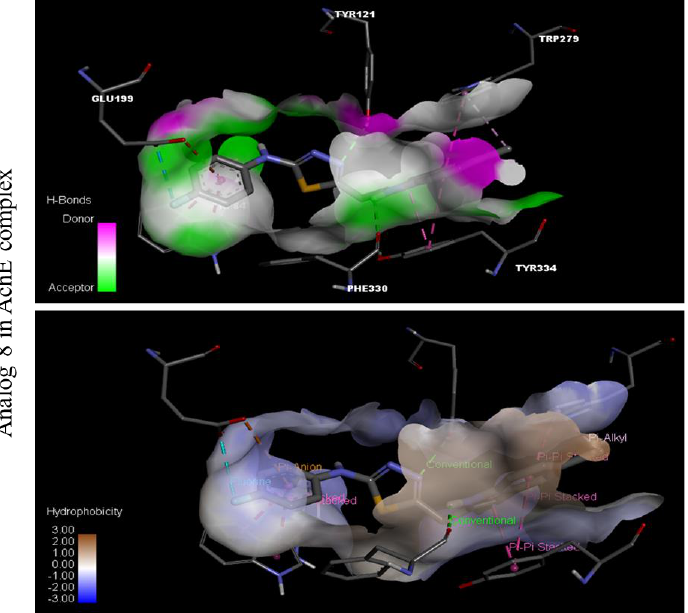
Figure 3. Indication of the hydrogen bond and hydrophobic nature against AChE of compound 8 .